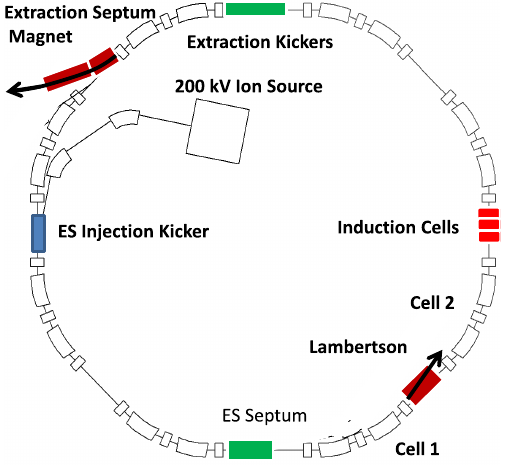
FIG. 5. Overview of the driver ring.